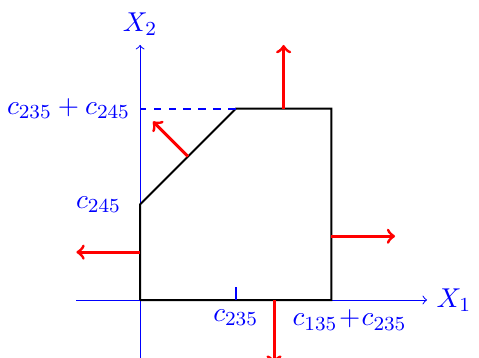
Figure 1. The polytope C (3 , 5) , combinatorially equivalent to the exchange graph [3] of the G(3 , 5) (or A 2 ) cluster